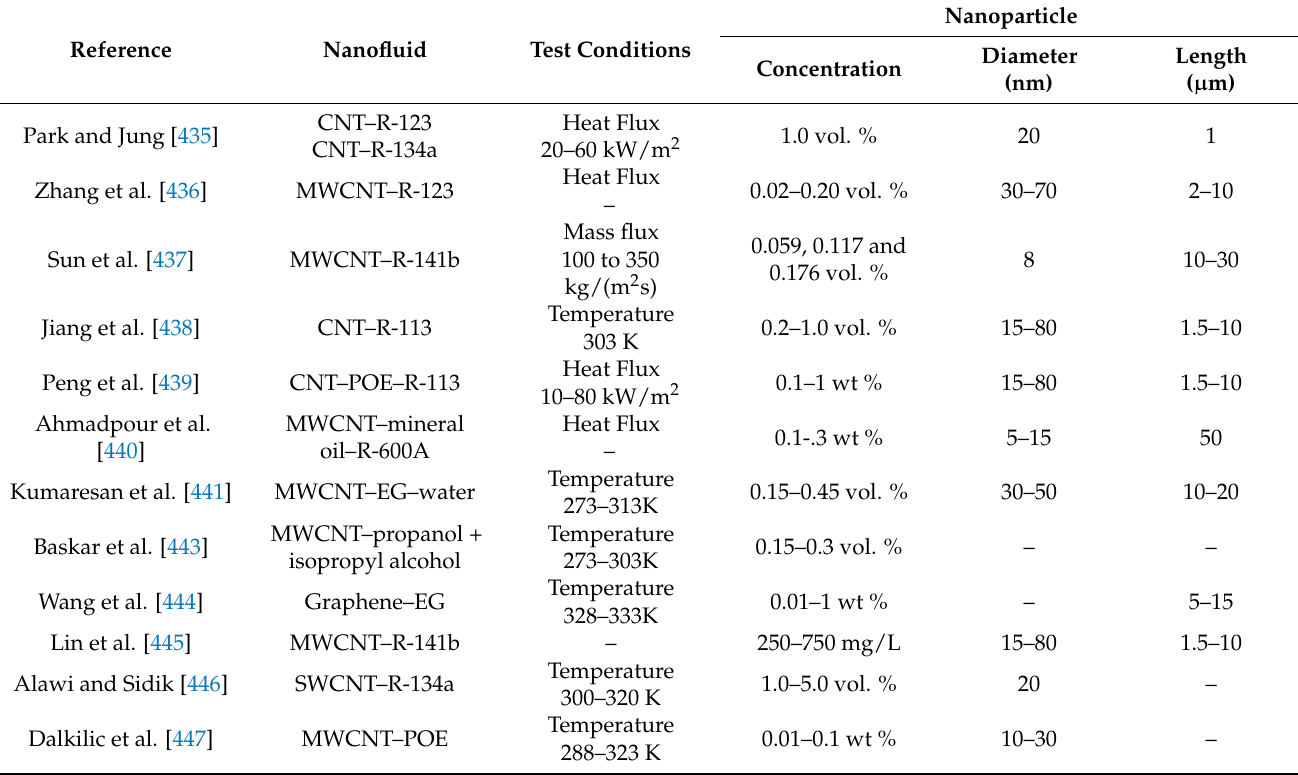
Table 10. List of studies related to carbon-based nanoparticles effect with working fluid in AC&R